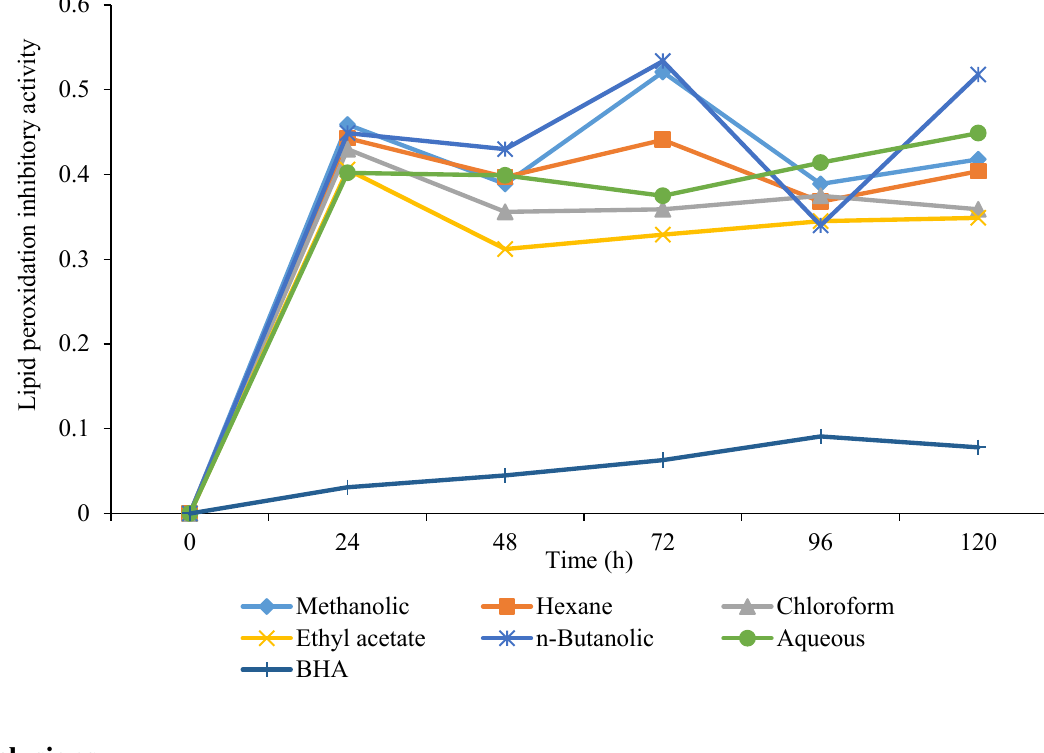
Figure 5. Lipid peroxidation inhibitory activity of methanolic extract of Carissa opaca roots and its fractions in various solvents and BHA ( n =